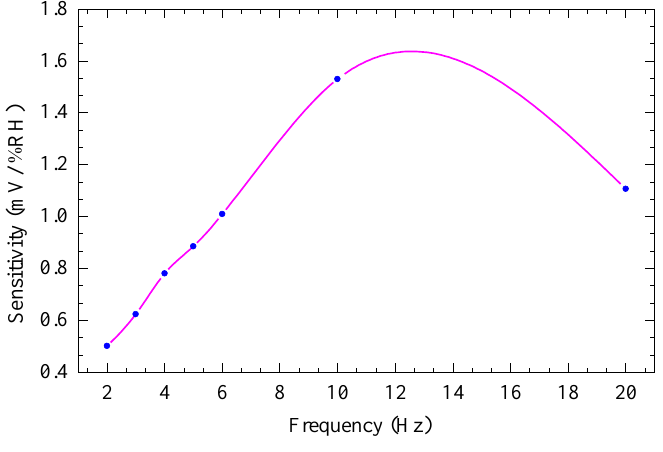
Figure 11. Sensitivity of the CMOS-MEMS humidity sensor vs.